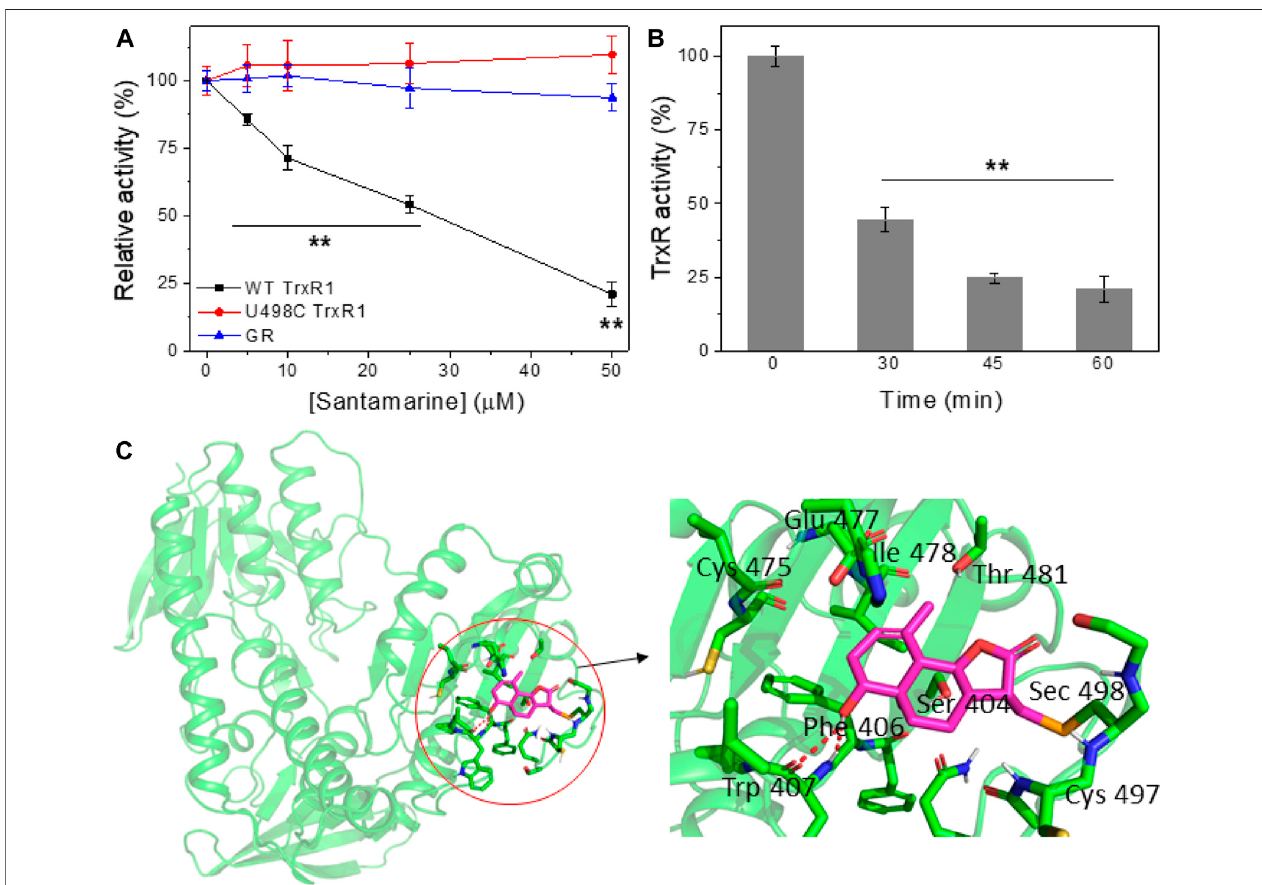
FIGURE3| SantamarineisreactivewithTrxR invitro . (A) TrxRwasinhibitedbysantamarineinadose-dependentmannercomparedwiththeU498CTrxRandGR. The speci fi ed concentrations of santamarine were added to NADPH-reduced WT TrxR1, U498C TrxR1 and GR, and the mixed system was subsequently incubated at room temperature for 2 h. The enzyme activity was fi nally detected by DTNB reduction. (B) TrxR activity was inhibited by santamarine in a time-dependent manner. Santamarine (50 μ M) and NADPH pre-reduced WT TrxR1 were incubated at room temperature for a speci fi ed time, and the activity was evaluated by DTNB method. (C) Molecular docking of santamarine and TrxR1 protein. The C-terminal position 498 of chain A of mouse TrxR1 was covalently docked with santamarine through the covalent docking protocol in the Schrödinger Suite 2015-1 program. The green cartoon indicates the monomer of TrxR1. The interaction between TrxR1 active site residues and santamarine is shown in orange and magenta sticks. The key residues around santamarine include Sec498, Cys497, Thr 481, Glu478, Ile477, Cys475, Trp407, Phe406, and Ser404. Data represent mean ± s. d. of three independent determinations. ** p < 0.01 vs. the U498C TrxR and GR groups in (A) , and the control group in (B)